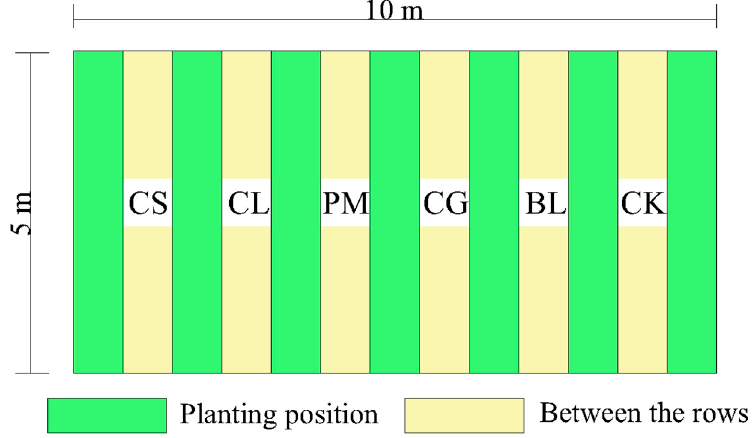
Figure 2. Schematic diagram of the experimental layout. CS— Camellia sinensis , CL— Cunninghamia